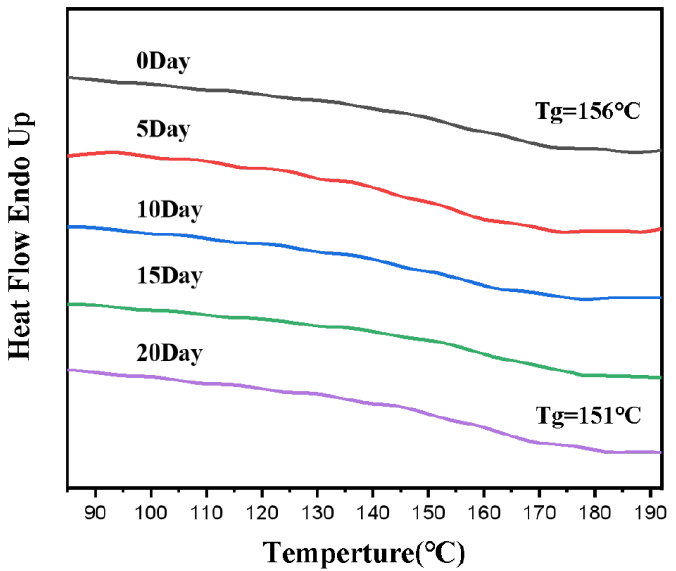
Figure 7. DSC curves of VAN-AC-EP/DDM after a wet-heat aging experiment.